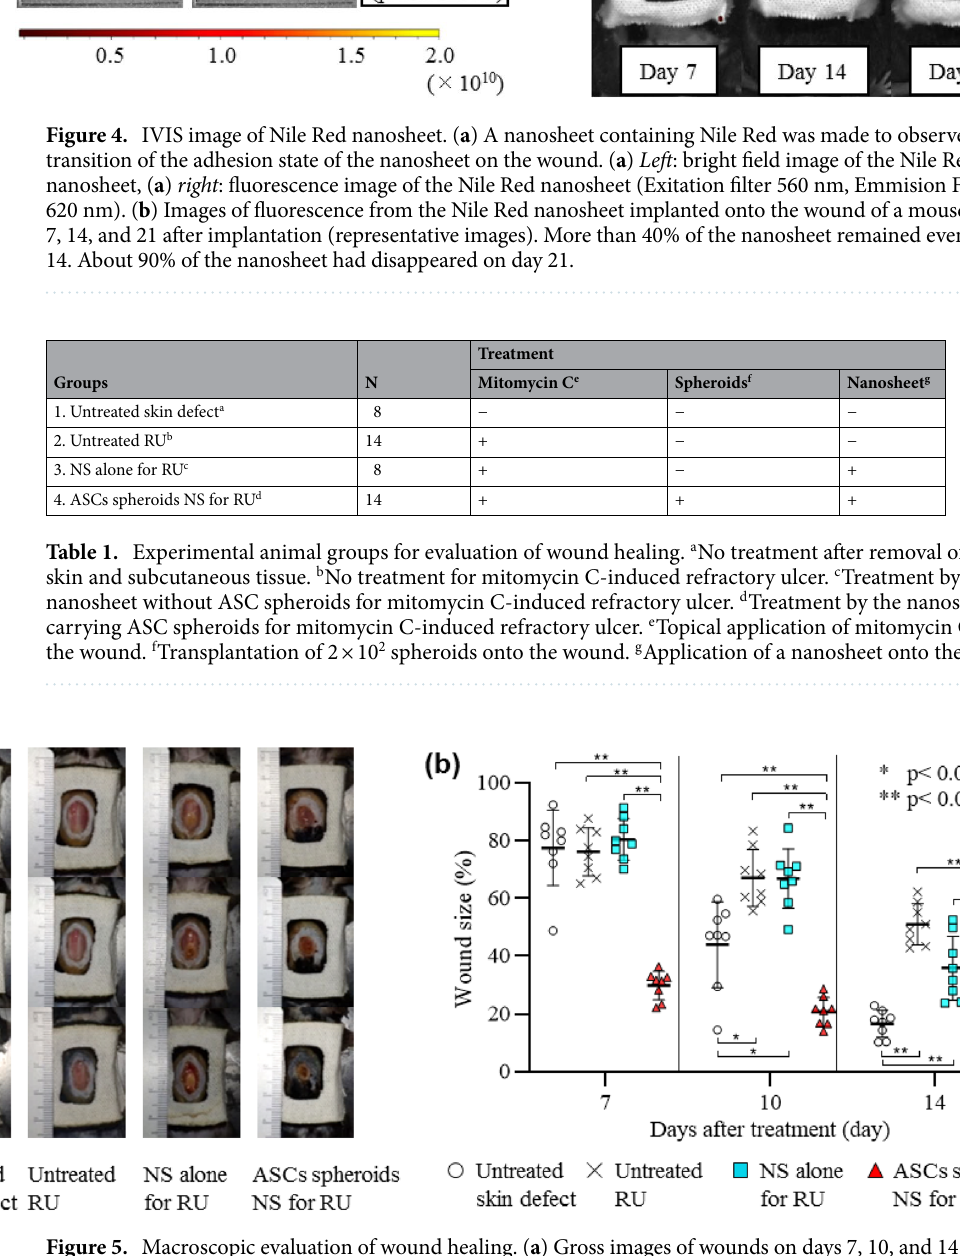
Figure 5. Macroscopic evaluation of wound healing. ( a ) Gross images of wounds on days 7, 10, and 14 after each treatment. ( b ) Comparison of wound sizes. The wound size on day 0 was defined as 100%. The wound size on day 14 in the animal group of ASC spheroids NS for RU is about 4-times smaller than that in the Untreated RU group (12.8 ± 4.7% vs. 49.1 ± 7.89%, p <